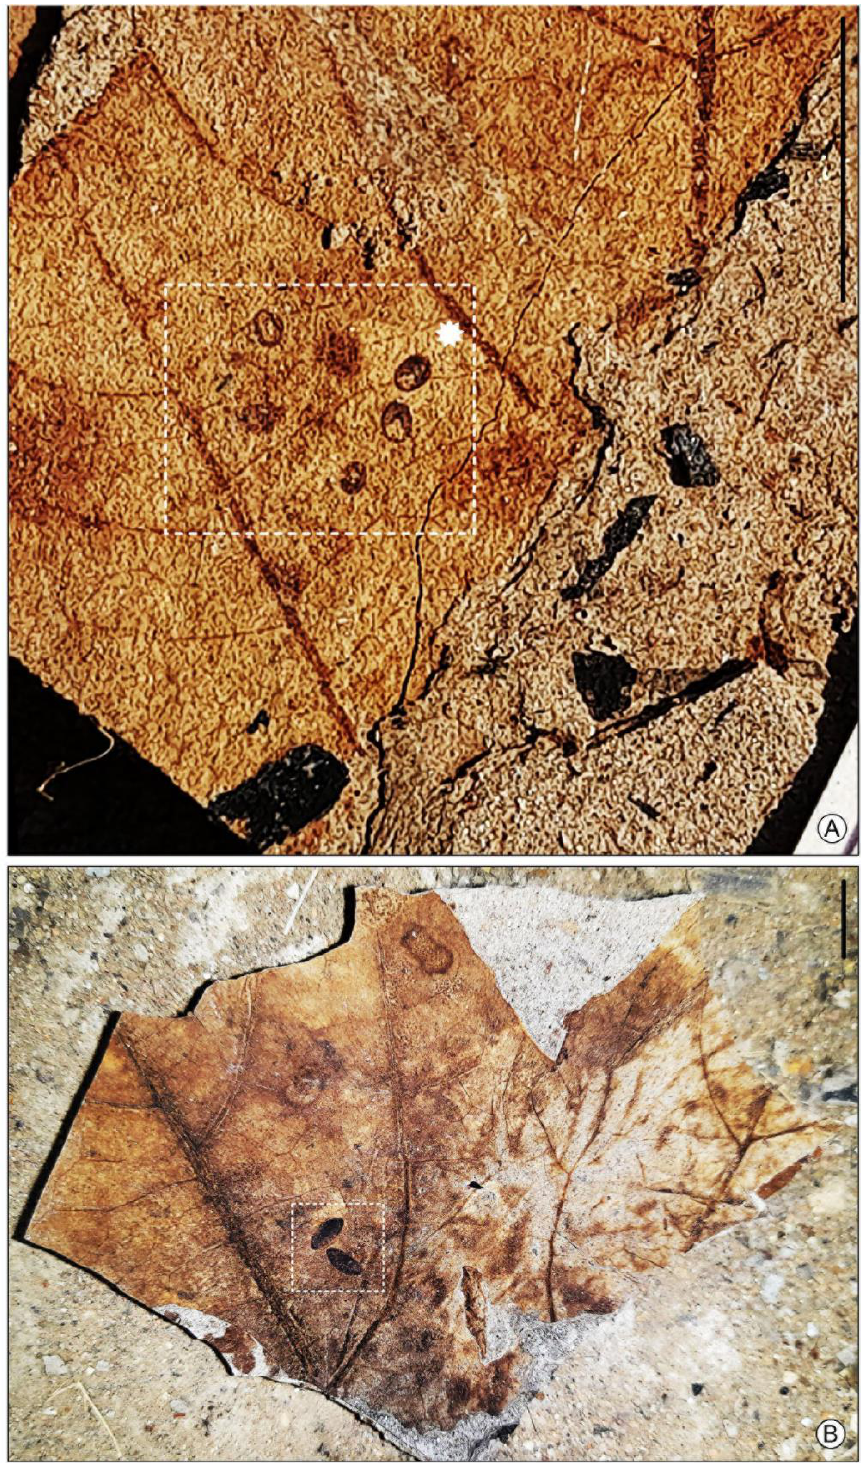
Figure 2. ( A ) Praealeurolobus indicus gen. et sp. nov. Type specimens. A fossil leaf showing well- preserved young puparia of whiteflies (SKBUH/PPL/JH/I2). An asterisk denotes the position of the holotype. ( B ) A fossil leaf showing probably pupal cases of Diptera (Cecidomyiidae?) (SKBUH/PPL/JH/I3)—position denoted by dotted box. Scale bar = 1 cm.